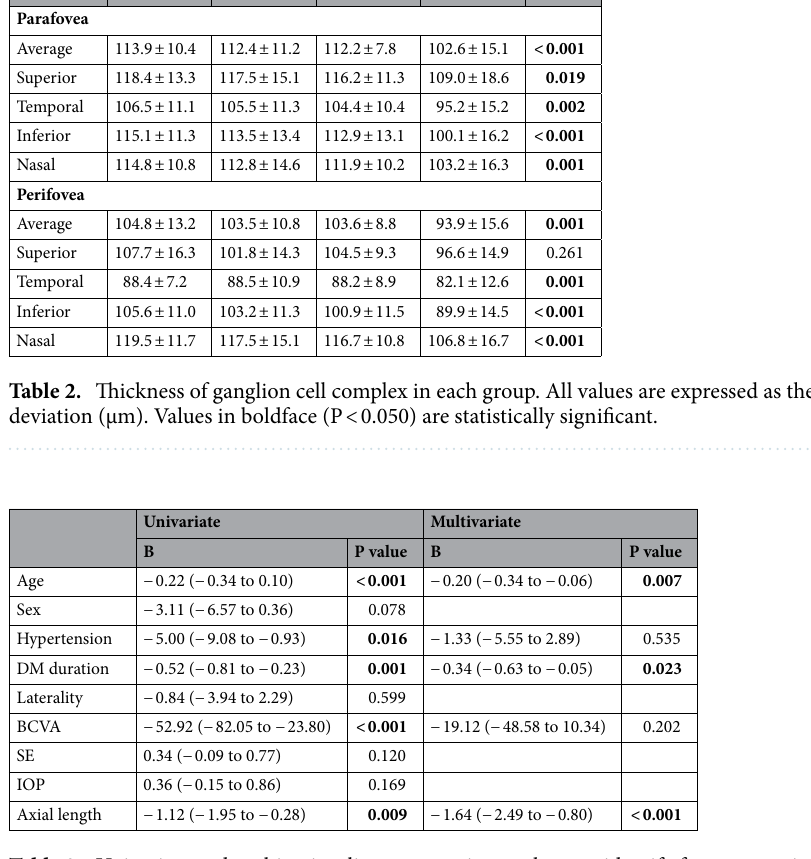
Table 3. Univariate and multivariate linear regression analyses to identify factors associated with parafoveal ganglion cell complex thickness. DM diabetes mellitus, BCVA best-corrected visual acuity, SE spherical equivalent, IOP intraocular pressure. Values in boldface (P < 0.050) are statistically